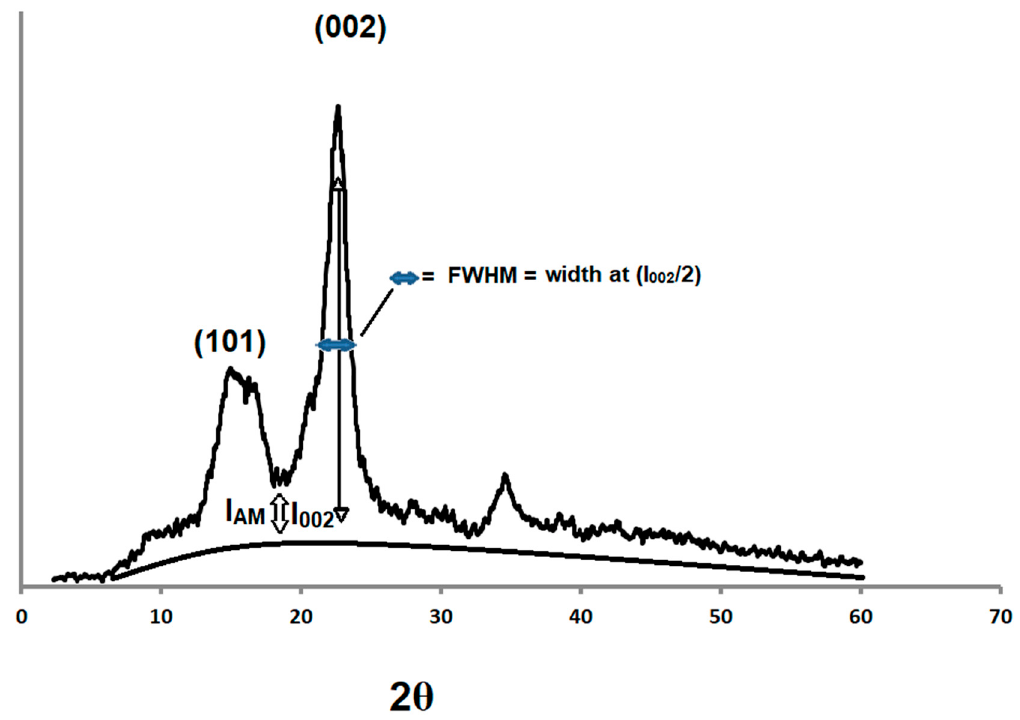
Figure 1. Illustrative demonstration of the peak heights of microcrystalline cellulose (MCC) used for the calculation of the CrI and full-width at half-maximum (FWHM) values.